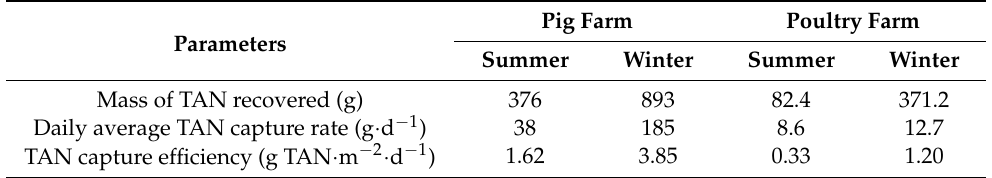
Table 2. Acidic solution TAN uptake data representative of one summer and one winter month for the two types of livestock farms